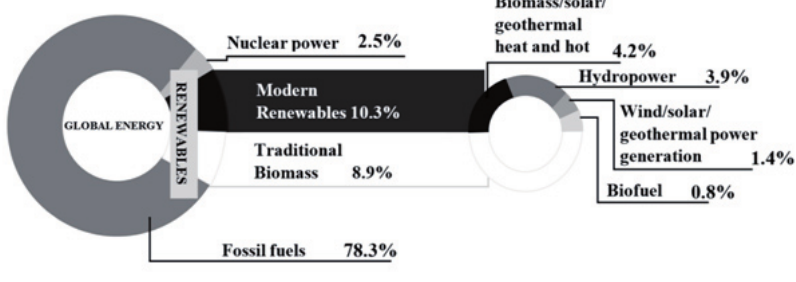
Fig. 1 – The contribution from renewables to the global final energy consumption in 2014. Source: IEA (2016) The share of “modern” renewables (not including traditional biomass) is still insignificant in the total renewable energy production worldwide, however, their use is steadily increasing. Bio- fuels used in transportation has spurred the development of bioenergy (Popp et al., 2014). The transport sector has a share of about 28% in the global final energy consumption (OECD/FAO, 2017). Transport biofuels constitute some 3%-4% of total road transport fuel and about 7% (3.5 EJ/year) of total bioenergy use today. Cuts in production costs will be crucial to make the next generation biofuels competitive. At the same time, a strong competition from other renewables (wind and solar) can be expected (Popp et al.,